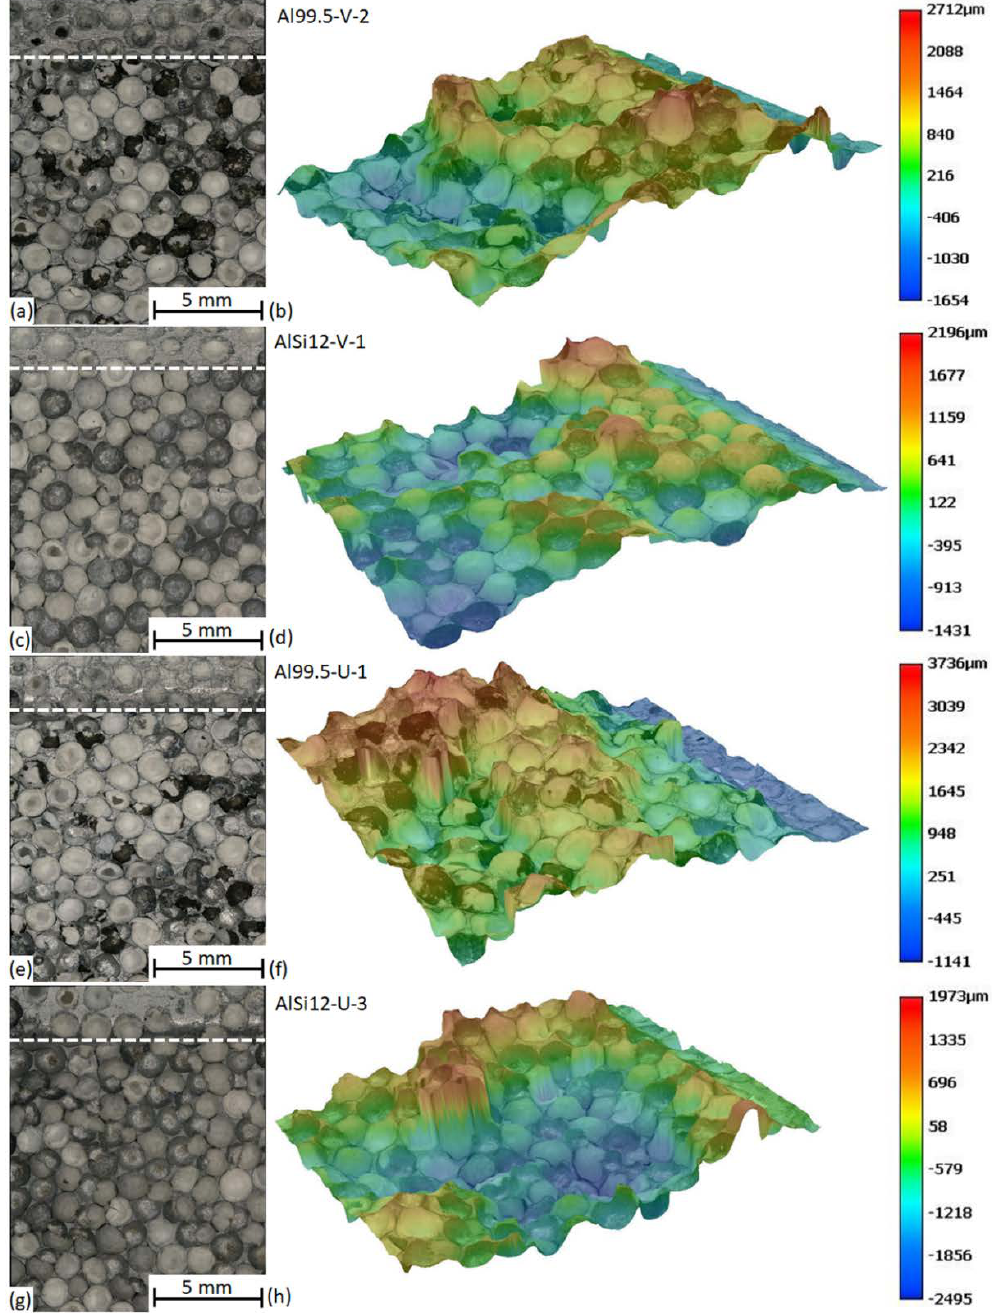
Figure 9. Typical fracture surfaces of MMSFs: ( a , b ) Al99.5-V-2, ( c , d ) AlSi12-V-1, ( e , f ) Al99.5-U-1, and ( g , h ) AlSi12-U-3 sample .